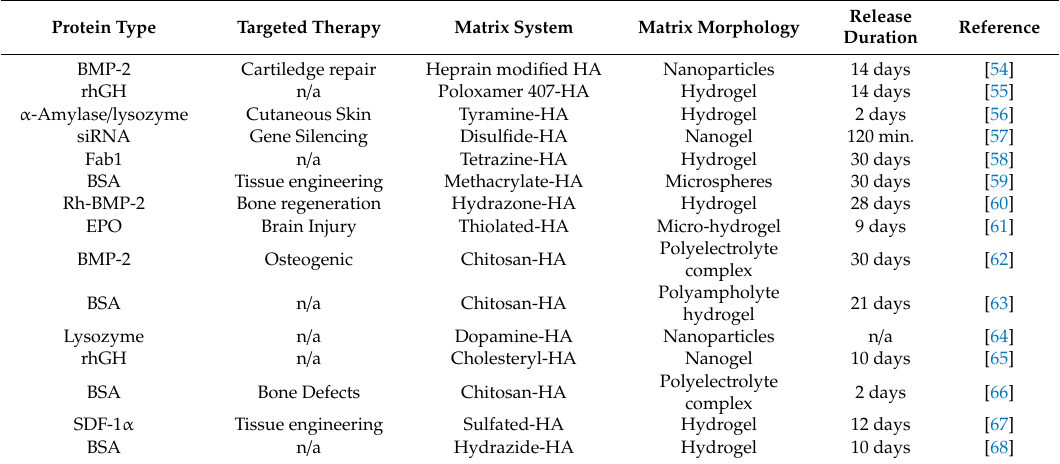
Table 1. Summary of protein release systems based on HA. Please see text for protein